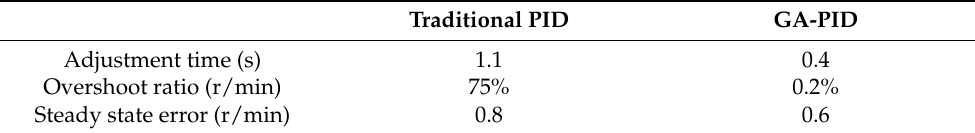
Table 5. Simulation data of rotation speed under the coal hardness of sudden change.